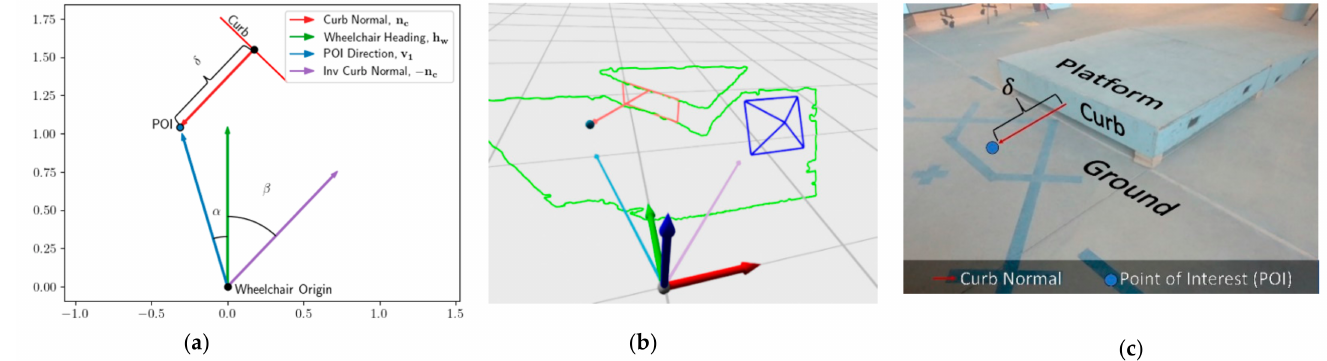
Figure 9. ( a ) Two-dimensional planar, ( b ) three-dimensional, and ( c ) image representations of the path-planning process, where the POI is the point at where the MEBot will arrive and is offset from the curb by δ . The dark blue lines in ( b ) represent the RealSense position and field of